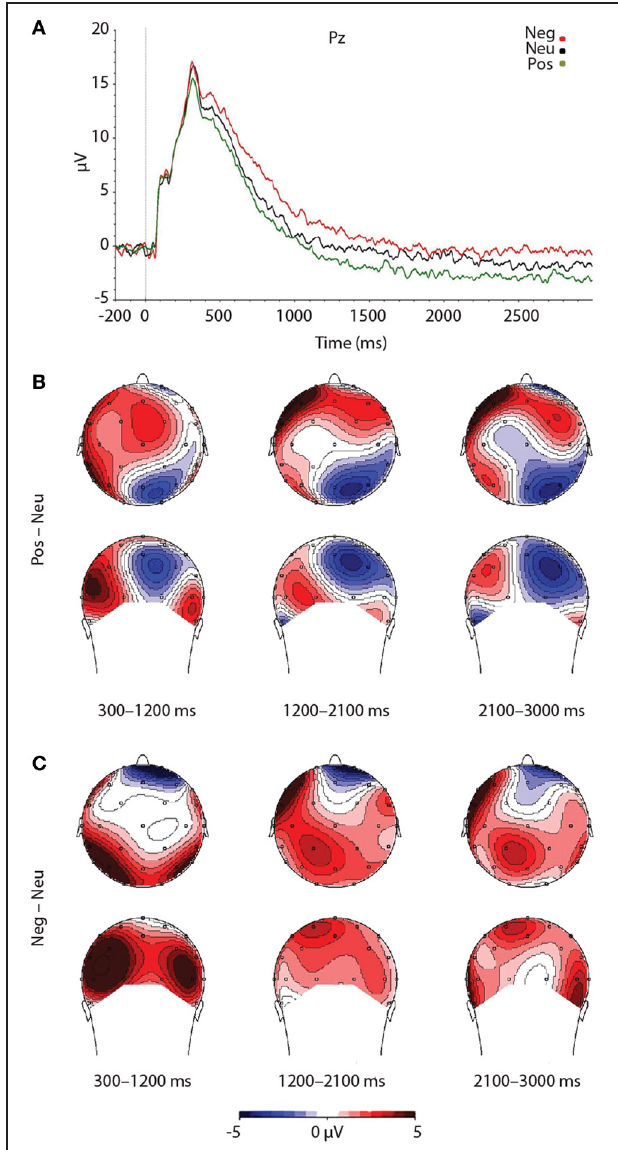
FIGURE 3 | Figure demonstrating: (A) Grand-averaged ERP waveforms of subjects during emotional picture presentation for each valence. The Pz sensor was selected for representing the LPP component over parietal regions, where the LPP was maximal. (B) Voltage difference maps across the LPP for negative images, relative to neutral images. (C) Voltage difference maps across the LPP for positive images, relative to neutral images. Neg, Negative; Neu, Neutral; Pos, Positive; µ V, microvolts; ms, milliseconds.